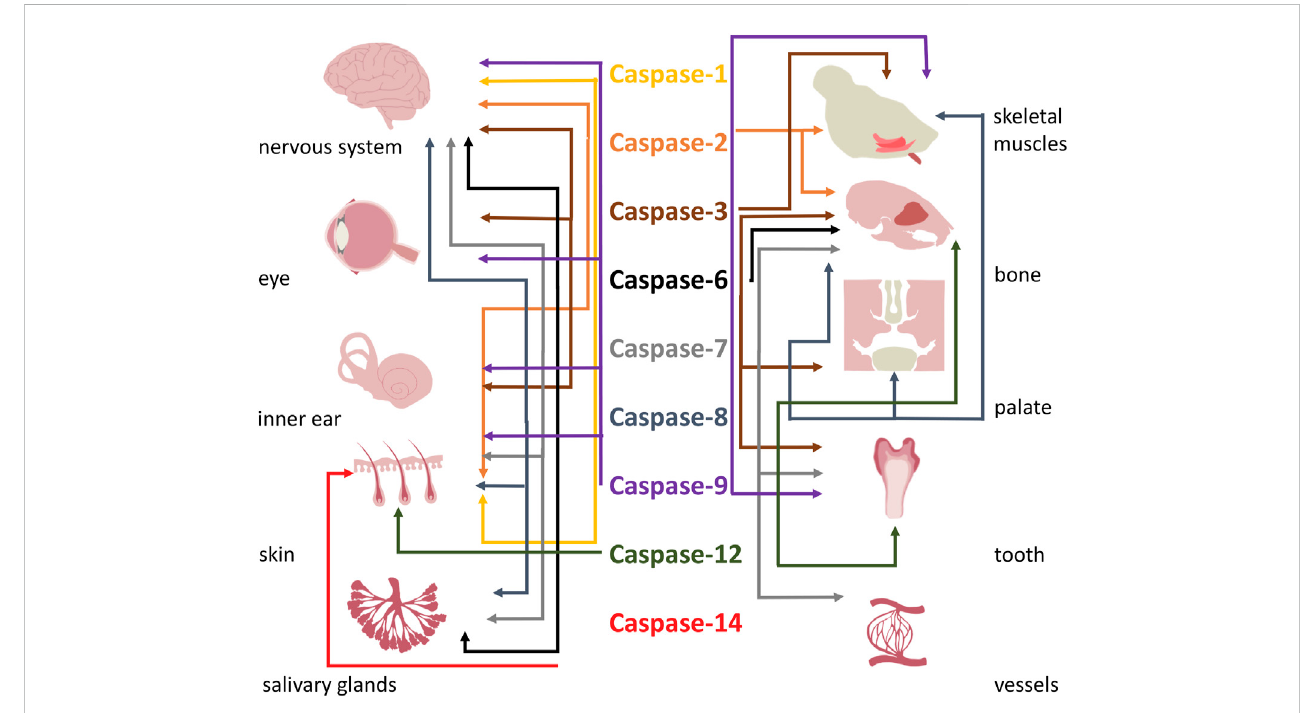
Overall functions of caspases in formation of